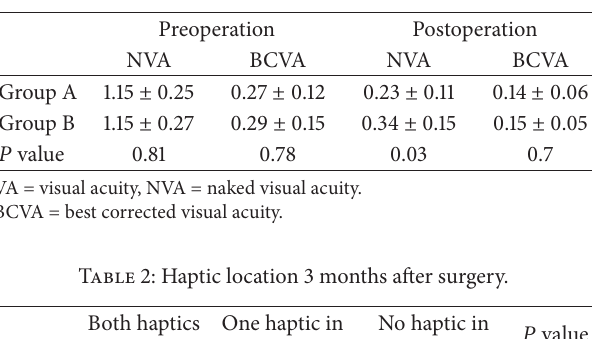
Table 1: Comparison of VA between two groups (logMAR).